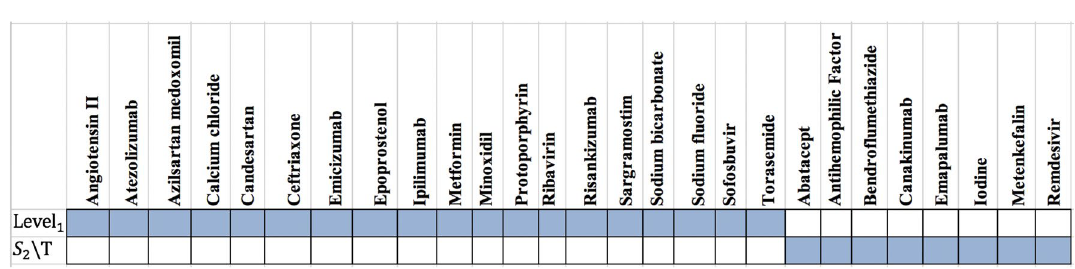
Figure 7. The presence (blue color) or absence (white color) of different approved drugs in Level 1 and S 2 \ T sets that are not approved with any of the proteins in S 2 set.The complete description of sets is presented in Table